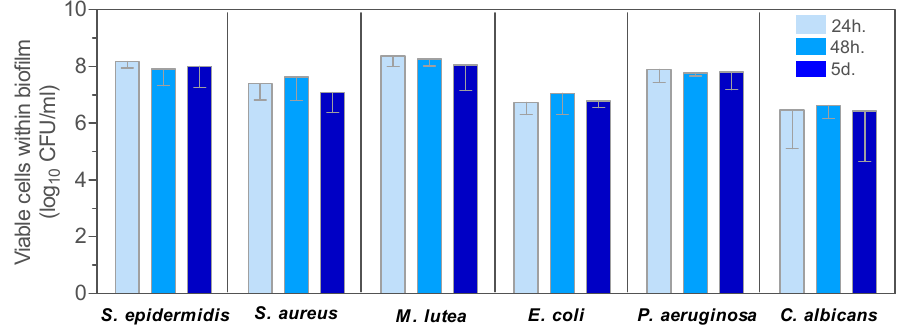
Figure 4. Evolution of viable cells within biofilms developed for 24 h, 48 h, or 5 days on control G1 pellets.